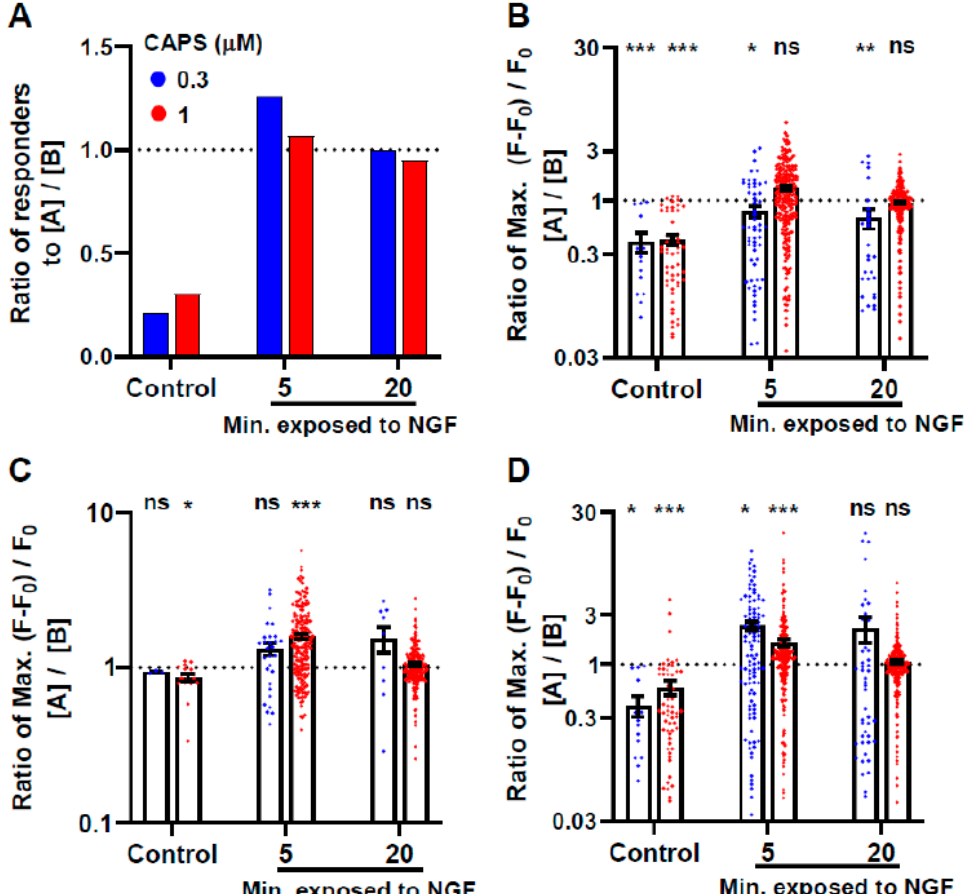
Figure 2. NGF attenuates CAPS tachyphylaxis. Response ratios (peak value obtained for second CAPS stimulation after [A]/peak value for first stimulation before [B] exposure to 100 ng/mL NGF) for the ( A ) number of responders or ( B – D ) Max. signal intensity evoked during the second exposure to 0.3 (blue) or 1 µ M CAPS (red) divided by the values elicited the first time when the DRG were stimulated with the same concentration of agonist. In ( B – D ), the calculations were restricted to cells that conformed to the following criteria: ( B ) neurons that produced above threshold signals to 0.3 or 1 µ M CAPS the first time each concentration was applied; note that both above and below threshold values elicited by the second stimulation with either agonist concentration were included in these analyses, ( C ) neurons excited above threshold both times the DRG were exposed to 0.3 or 1 µ M CAPS, ( D ) all DRGNs excited at least one time by either the first or second stimulation with 0.3 or 1 µ M CAPS; although the threshold criterion was used to identify the neurons to analyse, comparisons before and after NGF included values both above and below threshold. Paired two-tailed Student’s t-test were performed to compare the mean values of [A] and [B]; * p < 0.05; ** p < 0.01; *** p < 0.001; ns, not significant. Full statistical analysis and replicate numbers are detailed in Supplementary Tables